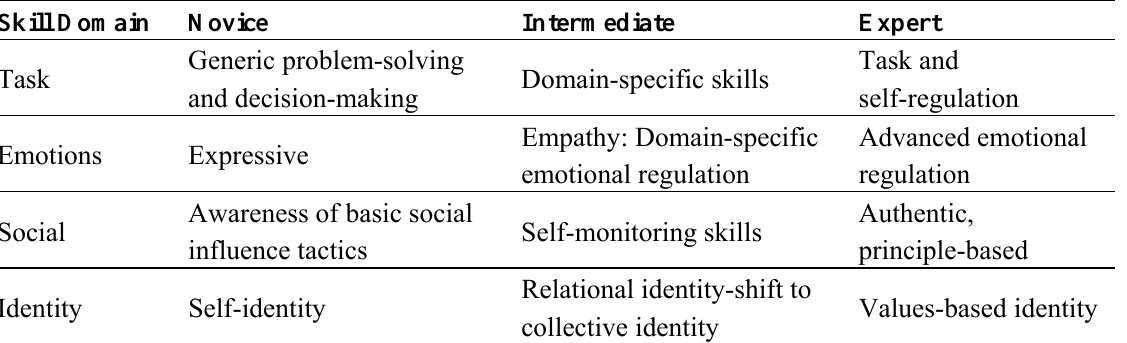
Table 1. The novice to expert leadership development